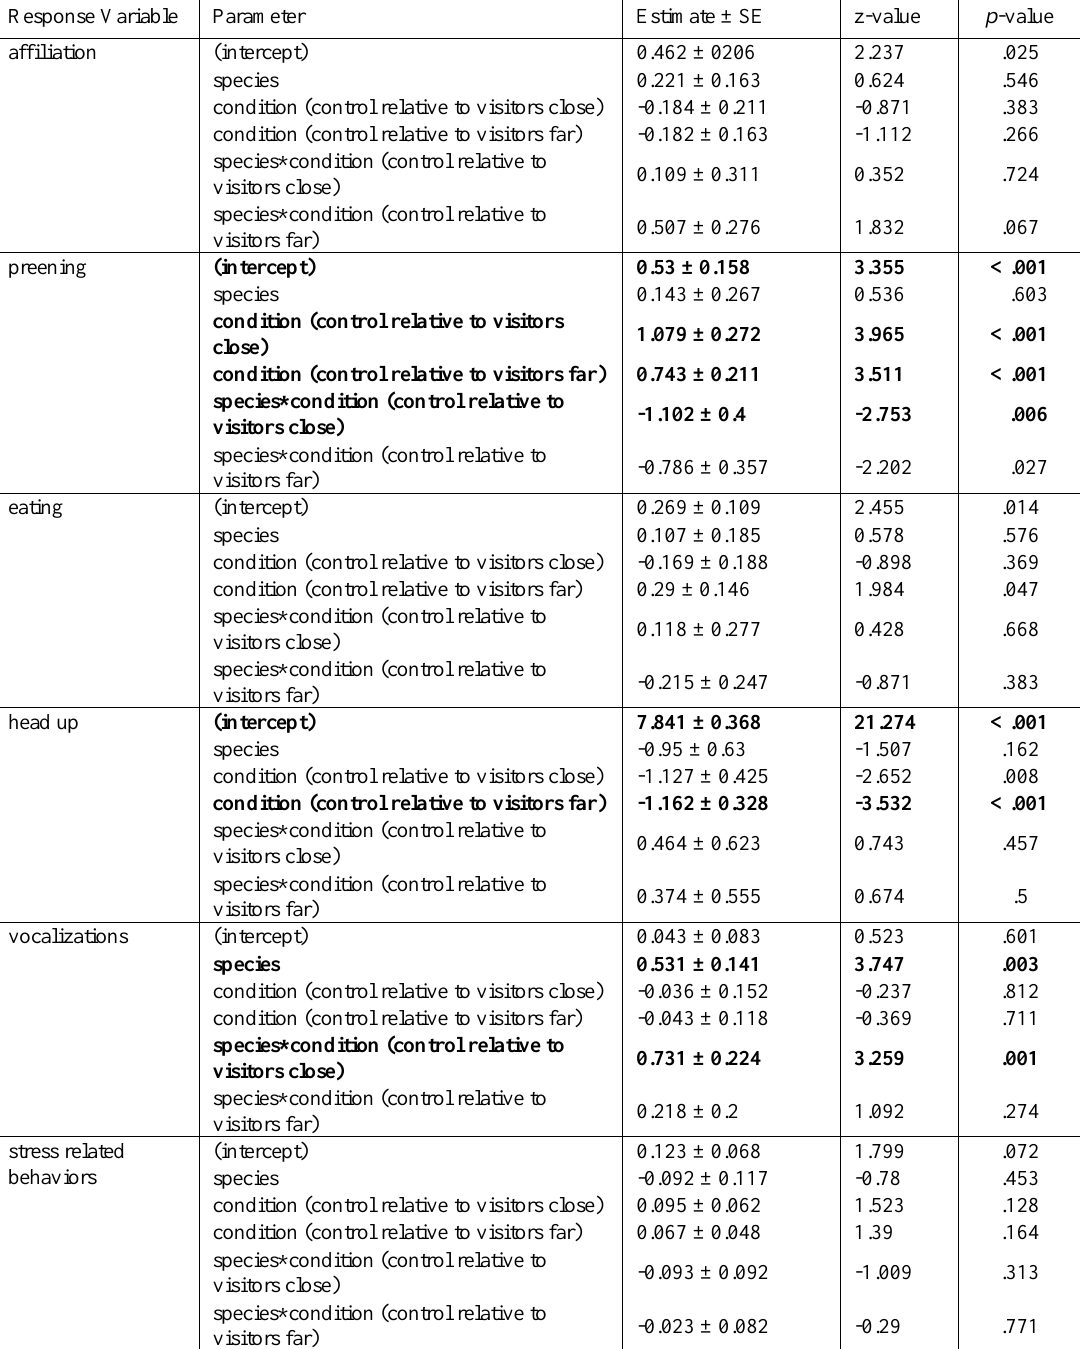
Table 1 Results of the Generalized Mixed Linear Model Investigating Factors Affecting Patterns of Behavior Response